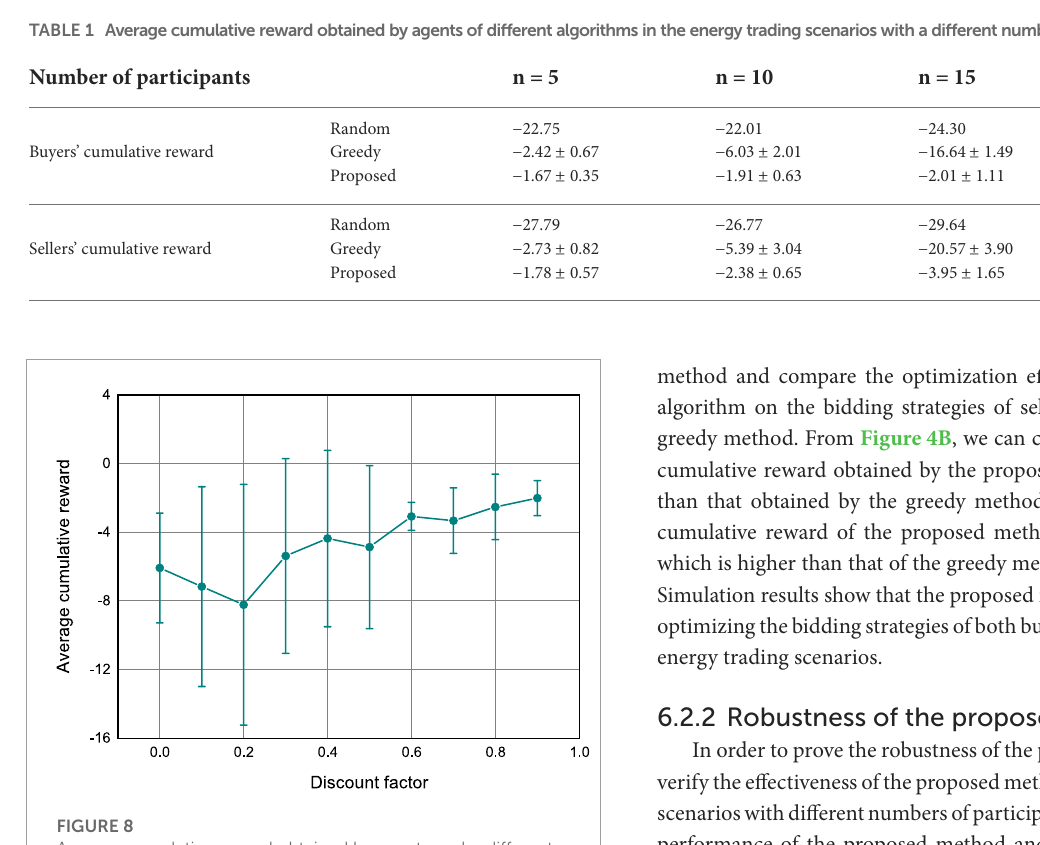
FIGURE 8 Average cumulative reward obtained by agents under different discount